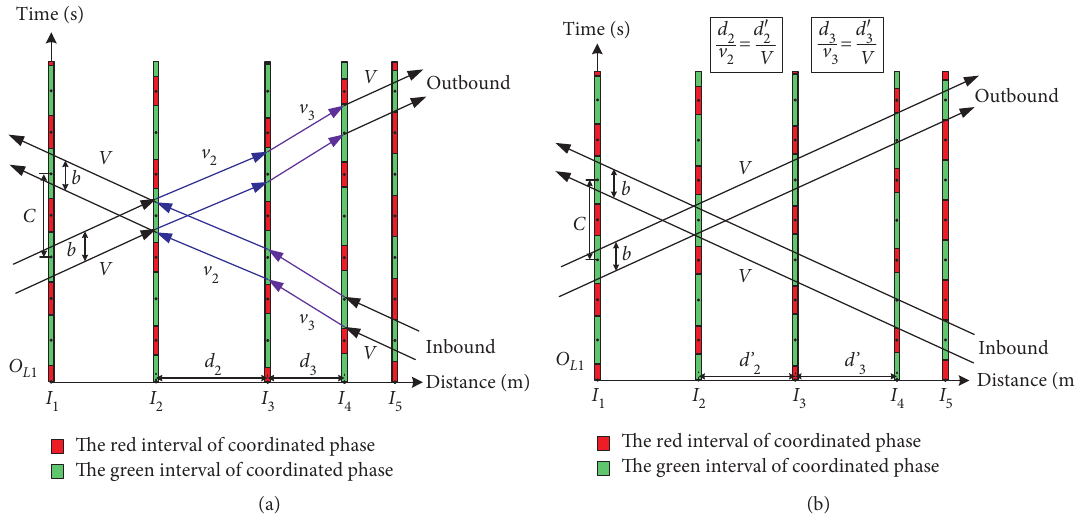
Figure 2: The horizontal scaling of the time-space diagram. (a) Before the horizontal scaling. (b) After the horizontal